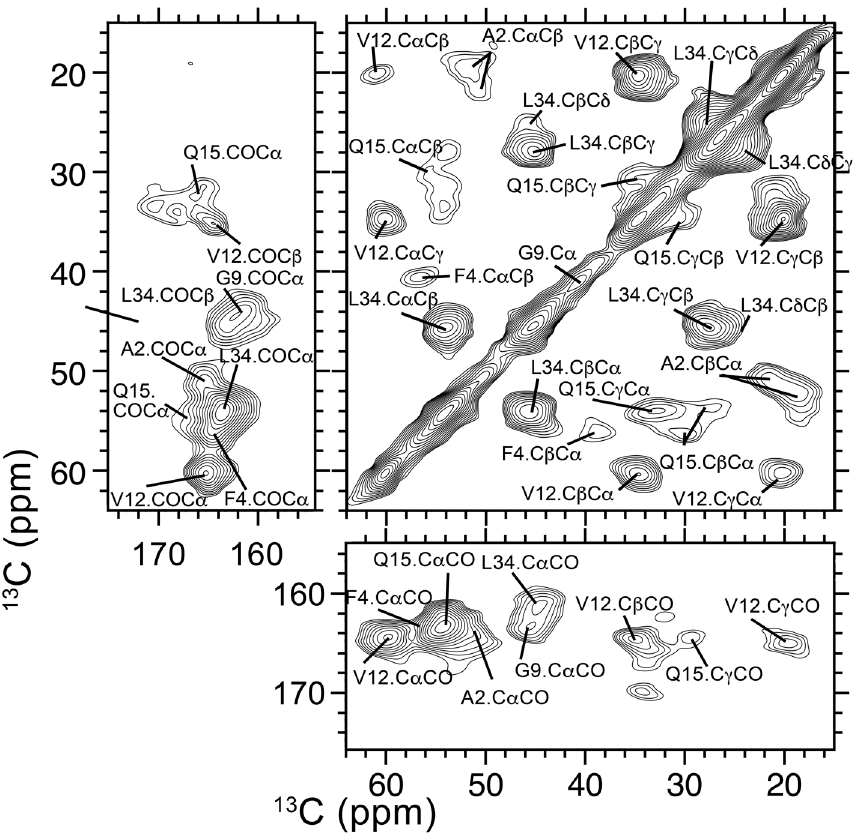
Figure 4. SSNMR spectra for unseeded Aβ40 fibrils, showing peaks for side chain carbon atoms (upper right panel), carbonyl atoms (lower right and upper left